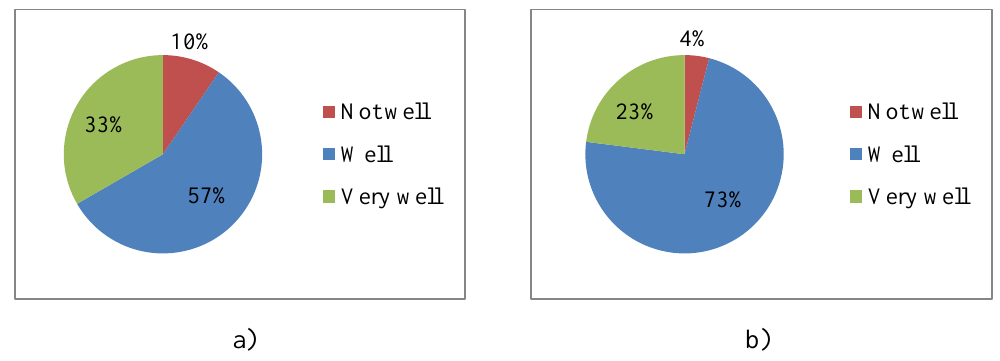
Fig. 5. Functioning of group as evaluated by students: a) workshop in Southampton; b) workshop in Lisbon (developed by the authors, based on survey